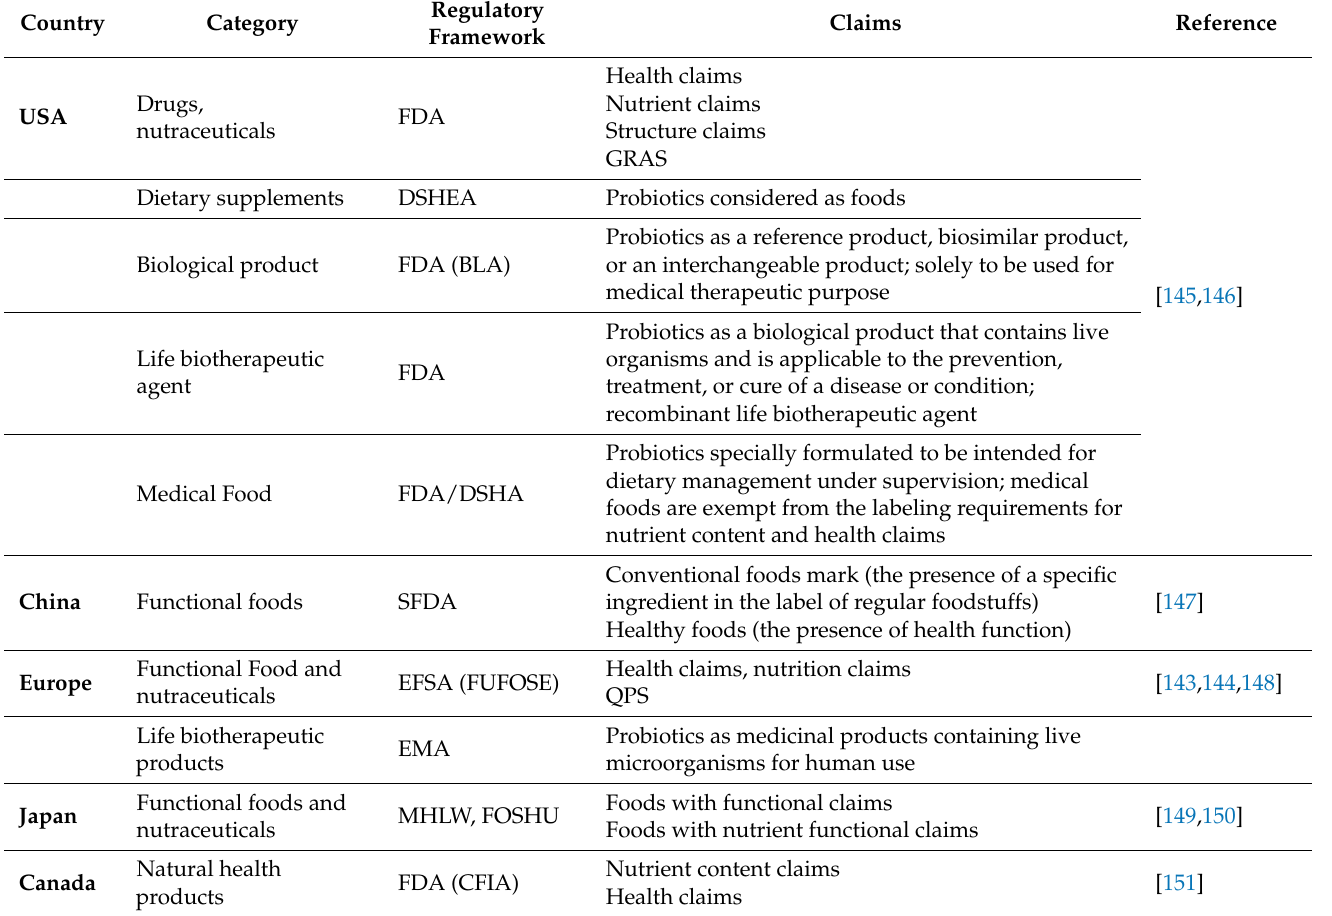
Table 5. Summary of probiotics categorization and regulation frameworks